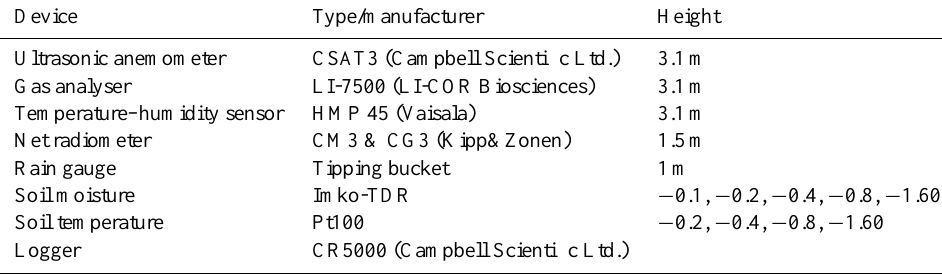
Table 4. Instrumentation of NamCo site in 2009 (25 June–8 August, only relevant instruments are